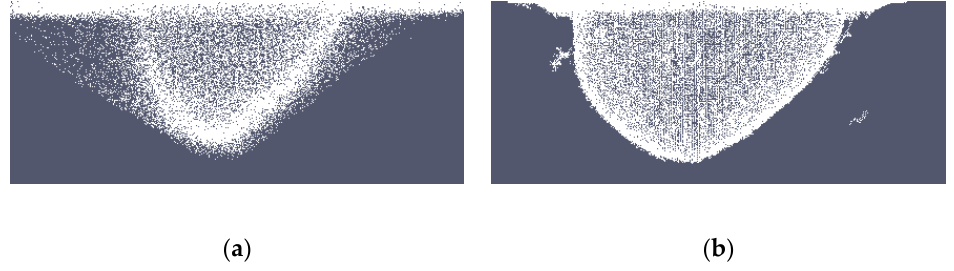
Figure A2. Cumulated approximatively aligned 3D point cloud: ( a ) From IFM O3D302 camera scan; ( b ) From Ensenso N10-804-18 camera scan.